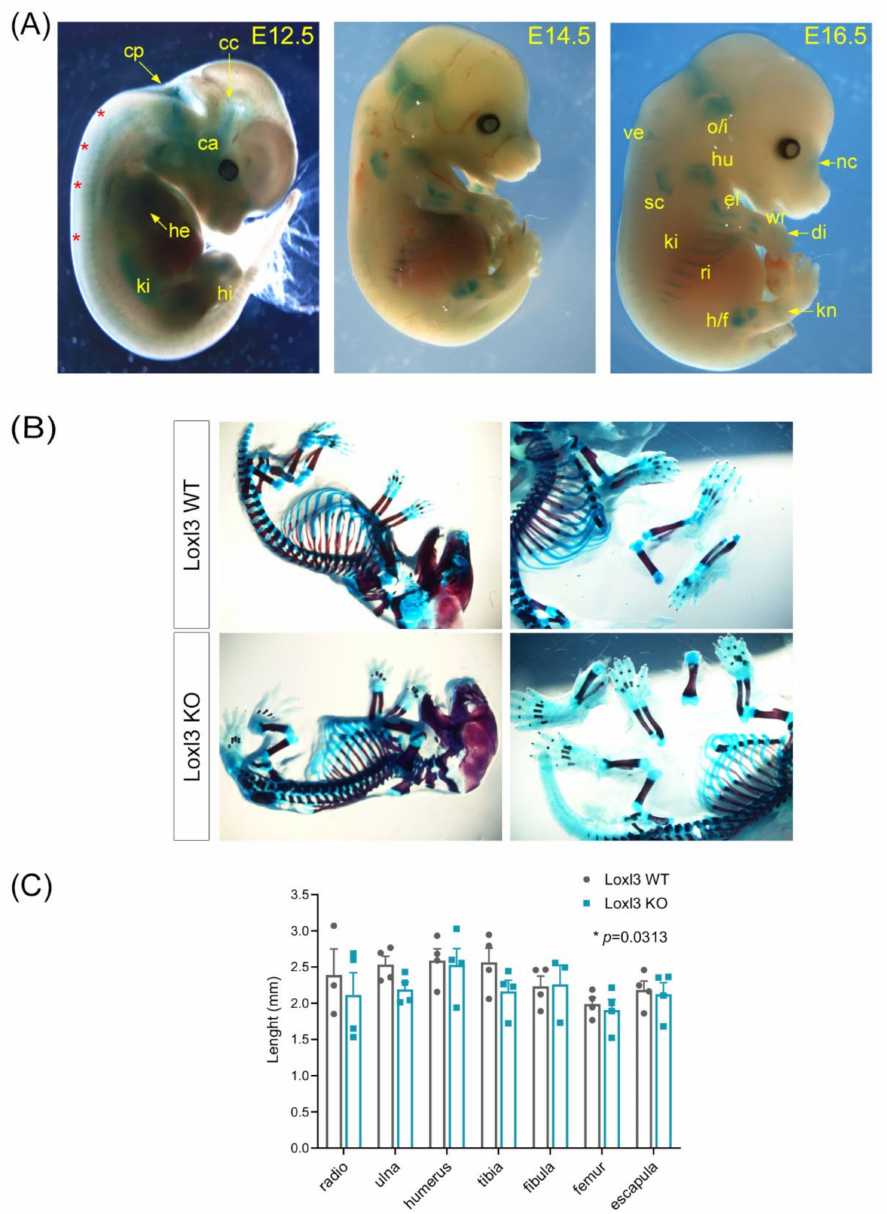
Figure 2. Loxl3 expression during embryogenesis is associated with mouse skeletal development. ( A ) Loxl3 expression pattern in embryos at indicated developmental stages as depicted by X-Gal staining. Red asterisks indicate axial staining; cp, choroid plexus; cc, chondrocranium; ca, cochlear area; he, heart; ki, kidney; hi, hindlimbs; o/i, occipital and interparietal cartilaginous precursors; ve, vertebrae; hu, humerus; nc, nasal cartilages; el, elbow; sc, scapula; wr, wrist; di, digits; ri, ribs; s/f, hip/femur; kn, knee. ( B ) Representative images of Loxl3 WT ( Loxl3 +/+ ) and KO ( Loxl3 LacZ / LacZ ) E18.5 embryos stained with alcian blue (cartilage)/alizarin red (bone) used to measure mineralised tissues. ( C ) Length (mm) of indicated bones from Loxl3 WT ( Loxl3 +/+ ) and KO ( Loxl3 LacZ / LacZ ) embryos (E18.5). Individual values and mean with SEM from WT (n = 4) and KO (n = 4) littermate embryos are shown. p value was calculated by Wilcoxon matched-pairs signed rank